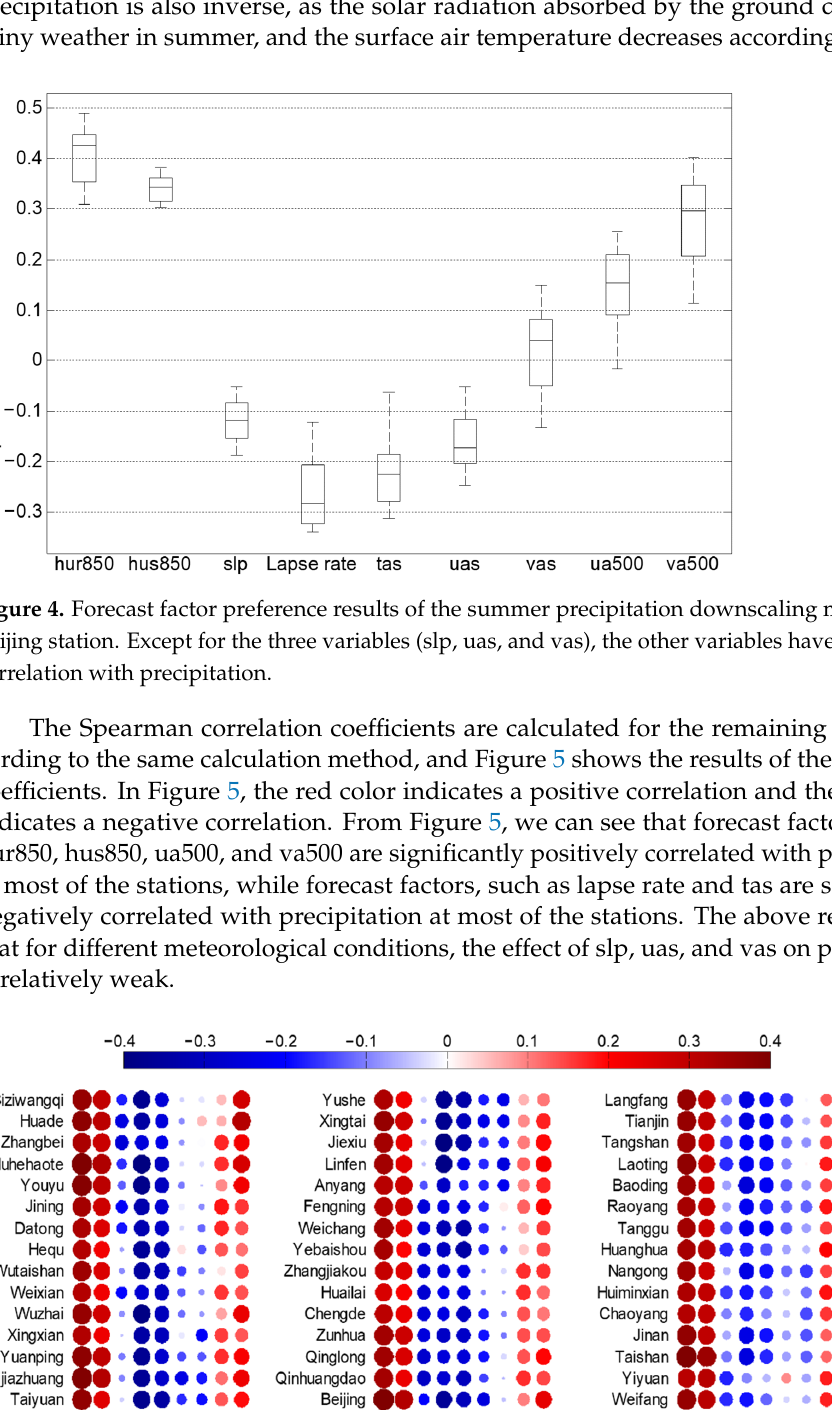
Figure 4. Forecast factor preference results of the summer precipitation downscaling model for the Beijing station. Except for the three variables (slp, uas, and vas), the other variables have a significant correlation with precipitation.